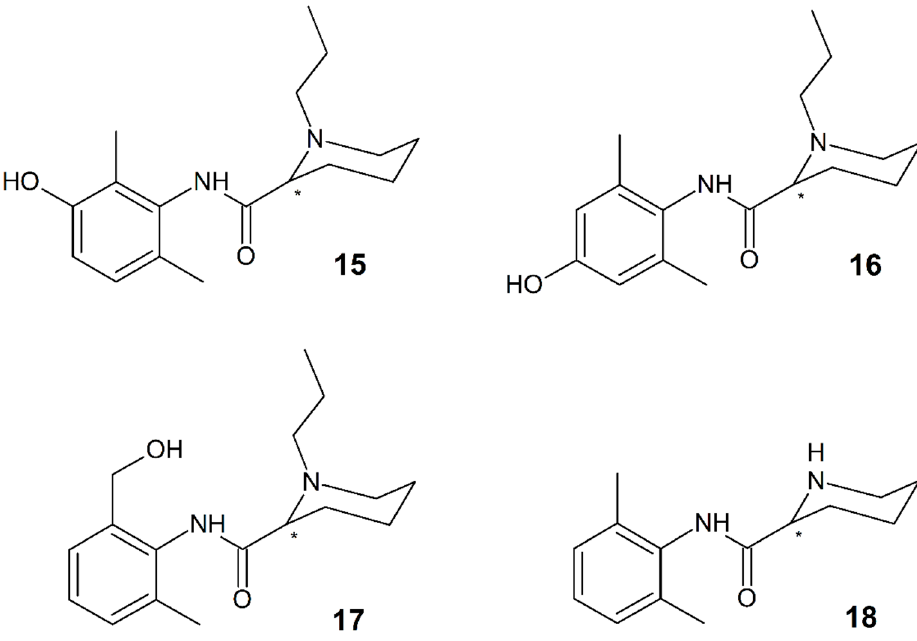
Figure 2. Selected metabolites of ropivacaine ( 6 ).